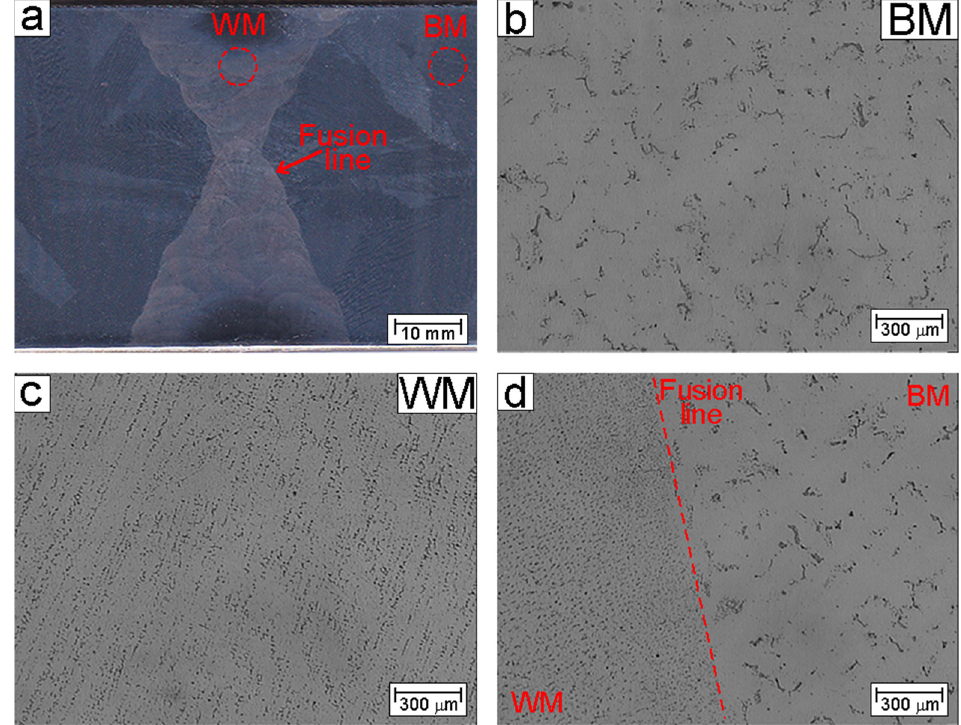
Figure 2. Macrograph of the cross-section of the multi-pass shielded metal arc welded CW6MC butt joint ( a ), BM ( b ), WM ( c ) and the interface BM/WM microstructure ( d ).